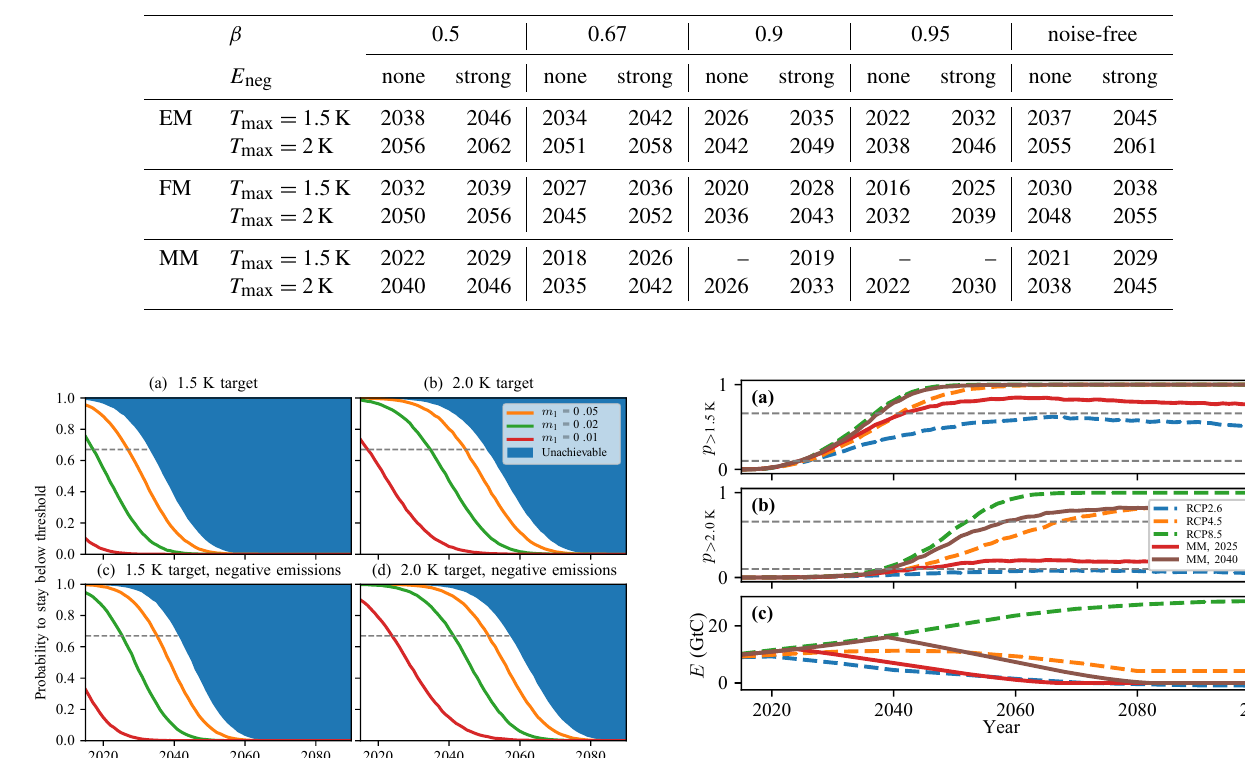
Figure 6. (a, b) Instantaneous probability to exceed 1.5K (a) and 2.0K (b) for different emission scenarios. RCP scenarios are shown as dashed lines while solid lines give MM scenario results starting in 2025 (red) and 2040 (brown). Dashed horizontal lines give p = 0 . 1 and 0.67, respectively. (c) Fossil fuel emissions inGtC for the same